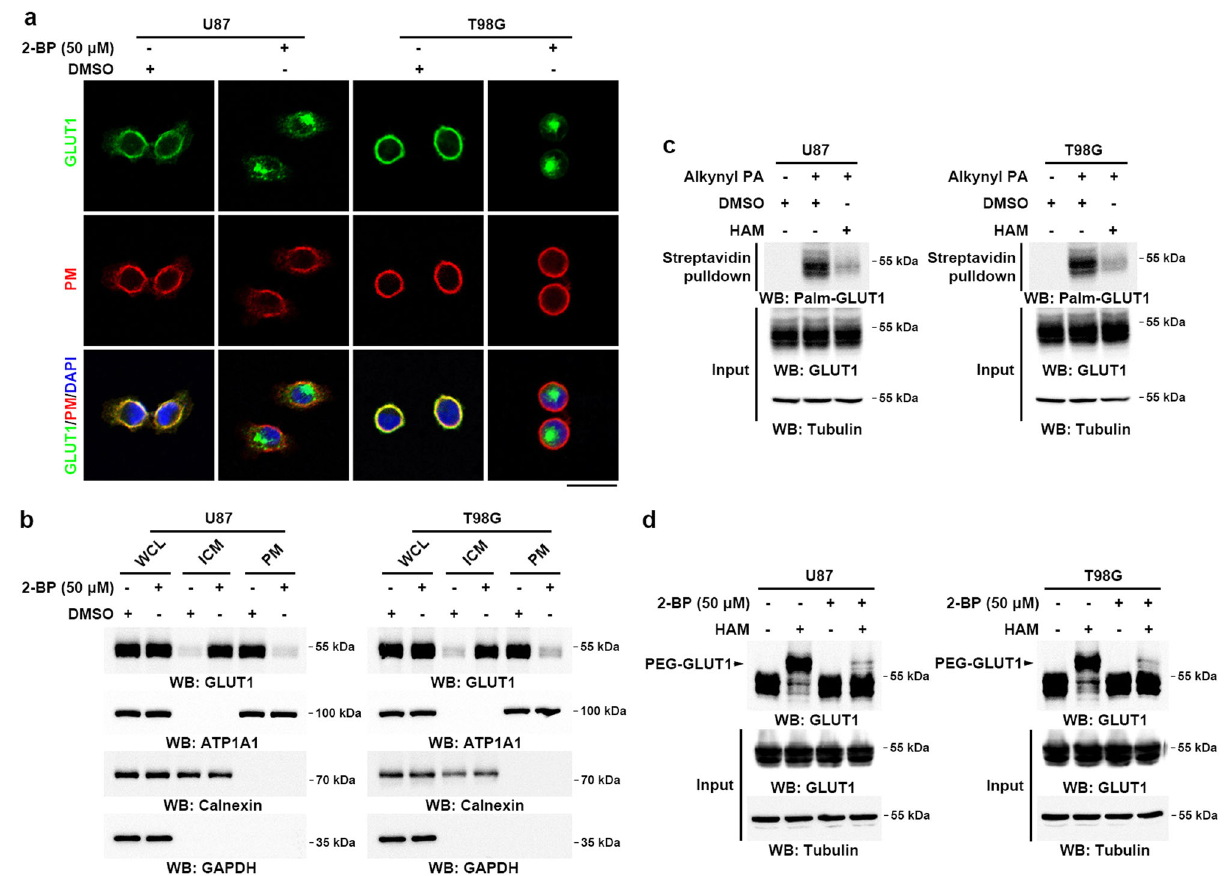
Fig. 1 S-palmitoylation is required for maintaining GLUT1 PM localization. a U87 or T98G cells were treated with DMSO or 50 μ M of 2-BP for 8 h followed by incubation with 1 µ g ml − 1 of cholera toxin subunit B (CTB) conjugated with Alexa Fluor 594 for 5 min at 37 °C. Endogenous GLUT1 cellular localization was visualized by immuno fl uorescent staining using antibodies against GLUT1. PM plasma membrane. Scale bar, 20 μ m. b U87 or T98G cells were treated with DMSO or 50 μ M of 2-BP for 8 h. Levels of GLUT1 in PM and ICM fractions were analyzed by immunoblotting. ATP1A1, calnexin, and GAPDH served as the marker of PM, ICM, and cytosol fraction, respectively. PM plasma membrane, ICM intracellular membrane, WCL whole-cell lysate. c GLUT1 palmitoylation was analyzed in lysates derived from U87 or T98G cells metabolically labeled with a palmitoylation probe (50 μ M alkynyl palmitic acid [PA]) for 4 h by click reaction and streptavidin bead pulldown in the absence or presence of hydroxylamine (HAM), followed by immunoblotting using indicated antibodies. d GLUT1 palmitoylation levels in U87 or T98G cells were analyzed by the APE assays, upon 50 μ M of 2-BP treatment in the absence or presence of HAM. PEG-GLUT1 bands indicated palmitoylated GLUT1. Representative results were obtained from at least three independent experiments with similar results. Source data are provided as a Source Data fi